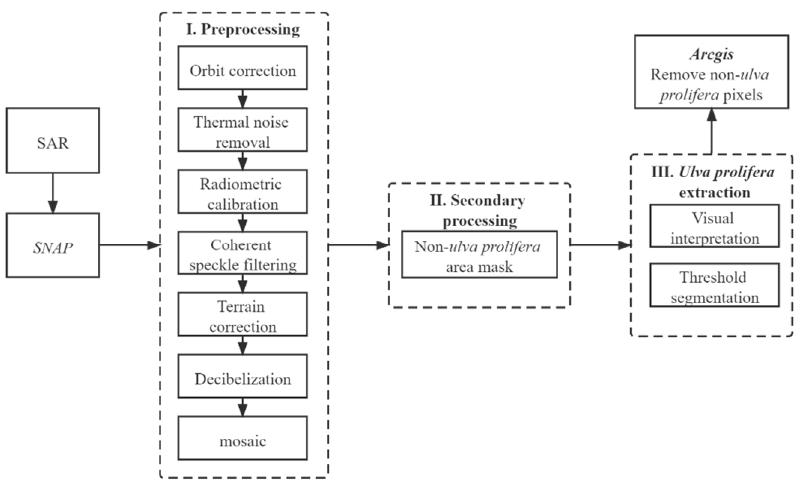
Figure 8. SAR image preprocessing flow